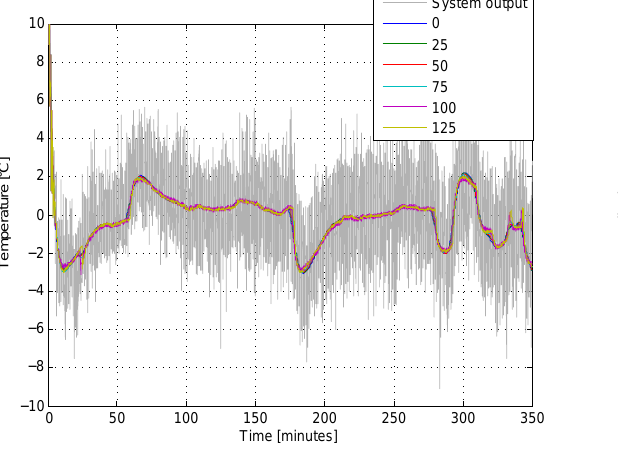
Figure 11: Bode magnitude diagram of the five success- ful polynomial OE